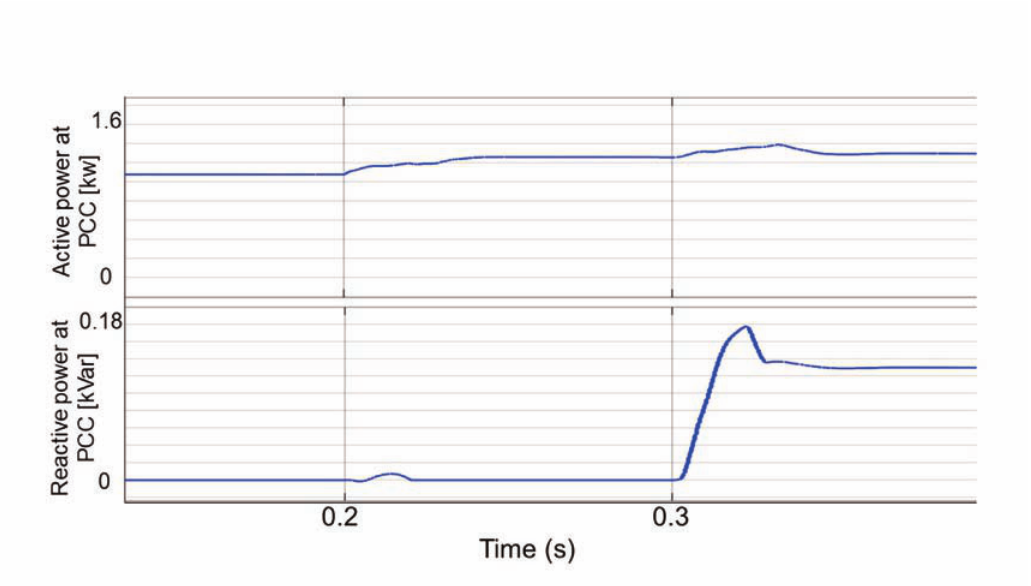
Fig. 10. Active and reactive power at PCC after enabling the conntroller and injecting Q.